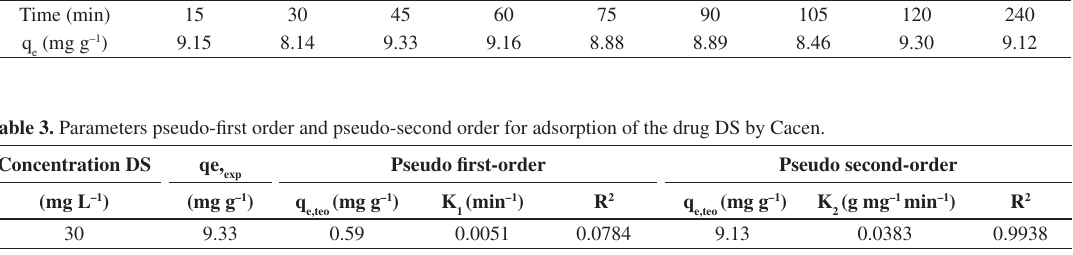
Figure 4. DSC of the Cpure (a), Cac (b) and Cacen (c). Figure 5. Influence of pH on the adsorption of DS Cacen. Table 2. Influence of the time of removal of diclofenac in the Cacen. Parameter Values